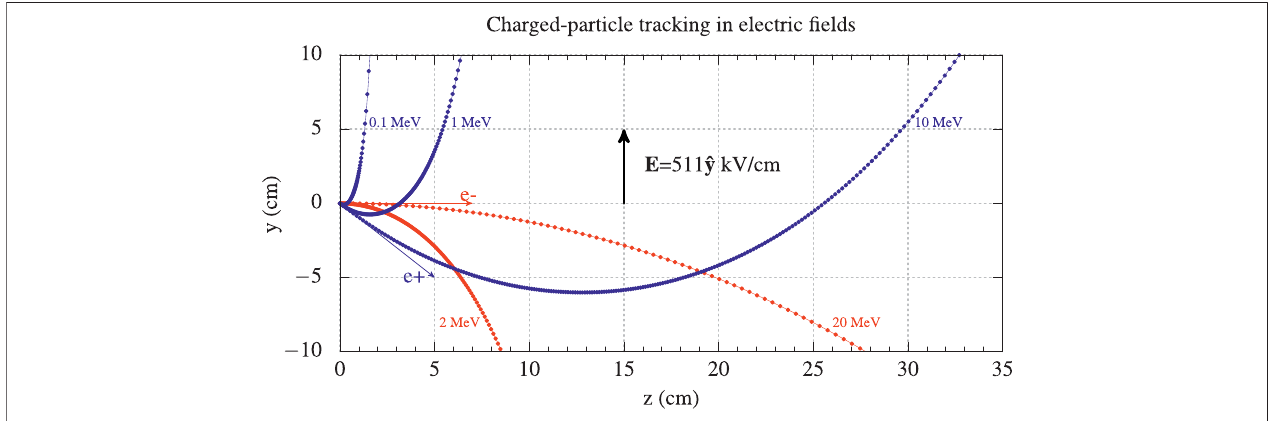
FIGURE1 | Comparison between FLUKA (dots) and analytical (solid curves) electron (red) and positron (blue) trajectories starting at the origin ofcoordinates along the direction indicated by the respective arrows, in a 511 kV/cm electric fi eld along the y axis for energies ranging from 0.1 to 20 MeV as per the fi gure labels.